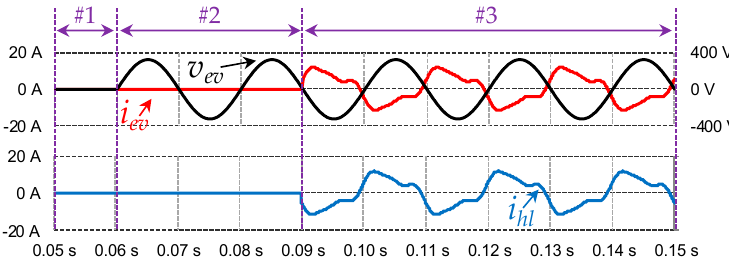
Figure 10. The principle of operation representative of the V2L mode (as a voltage source).